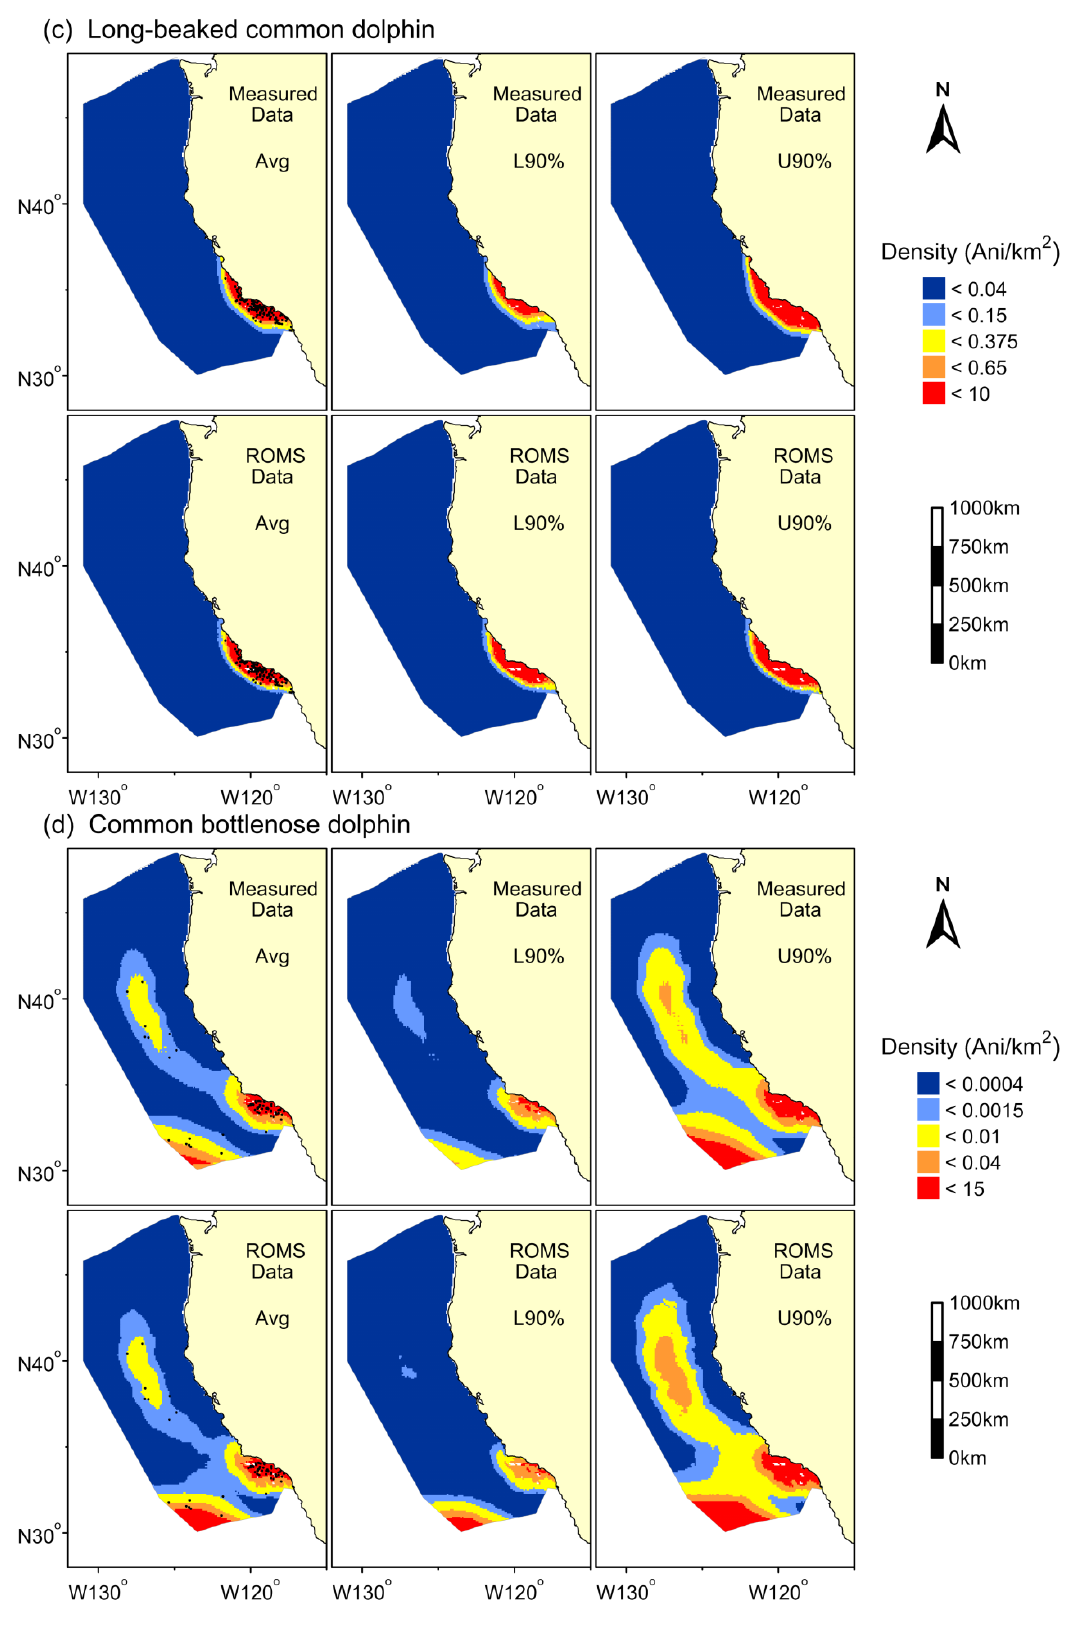
Figure 2. Cont. Figure 2.